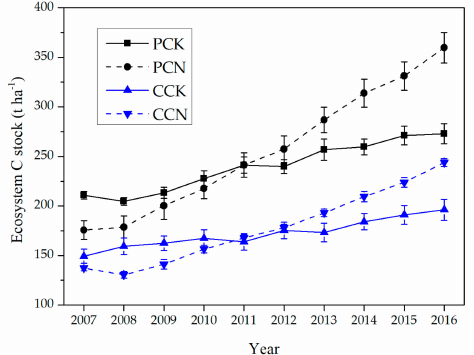
Figure 2. Dynamics of ecosystem C stock in the four plantations (mean ± standard error, n = 4). PCK, PCN, CCK, and CCN represent the pure and near natural managed P. massoniana plantation and the pure and near natural managed C. lanceolata plantation, respectively.